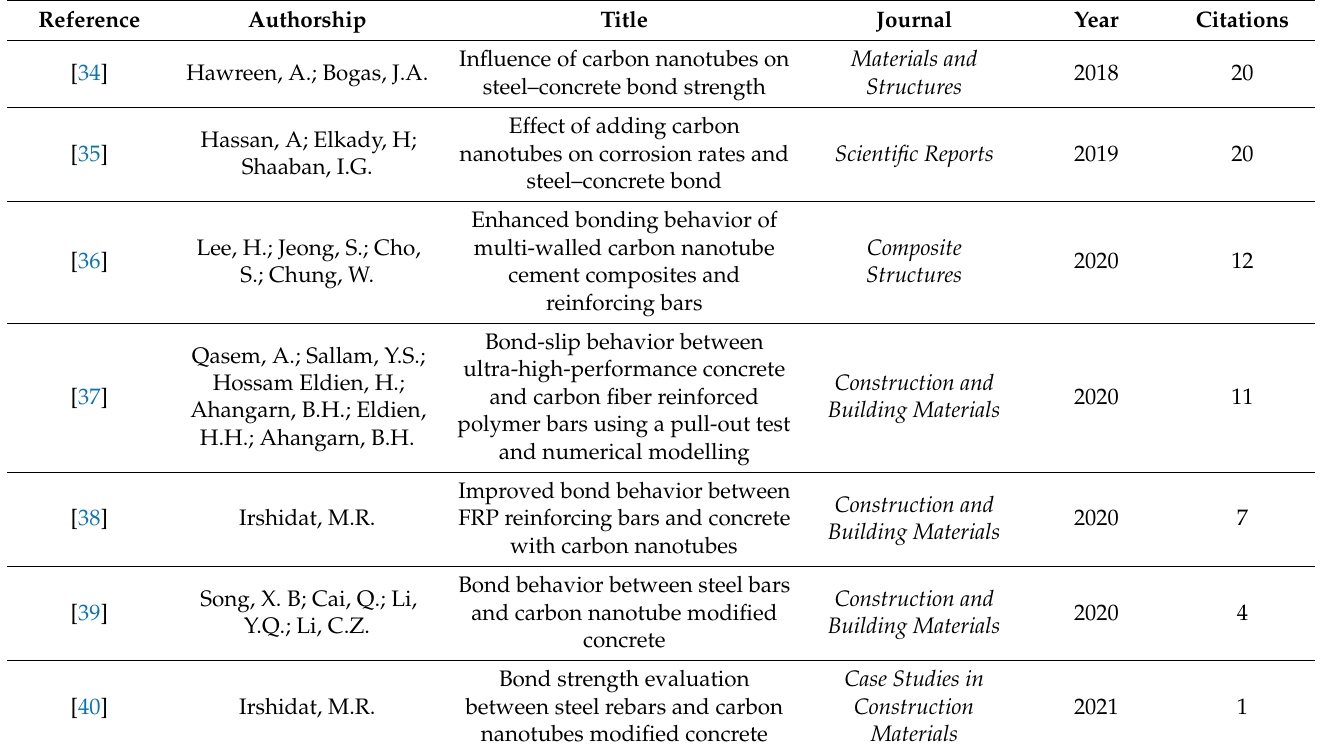
Table 1. Details of the articles selected applying the ProKnow-C